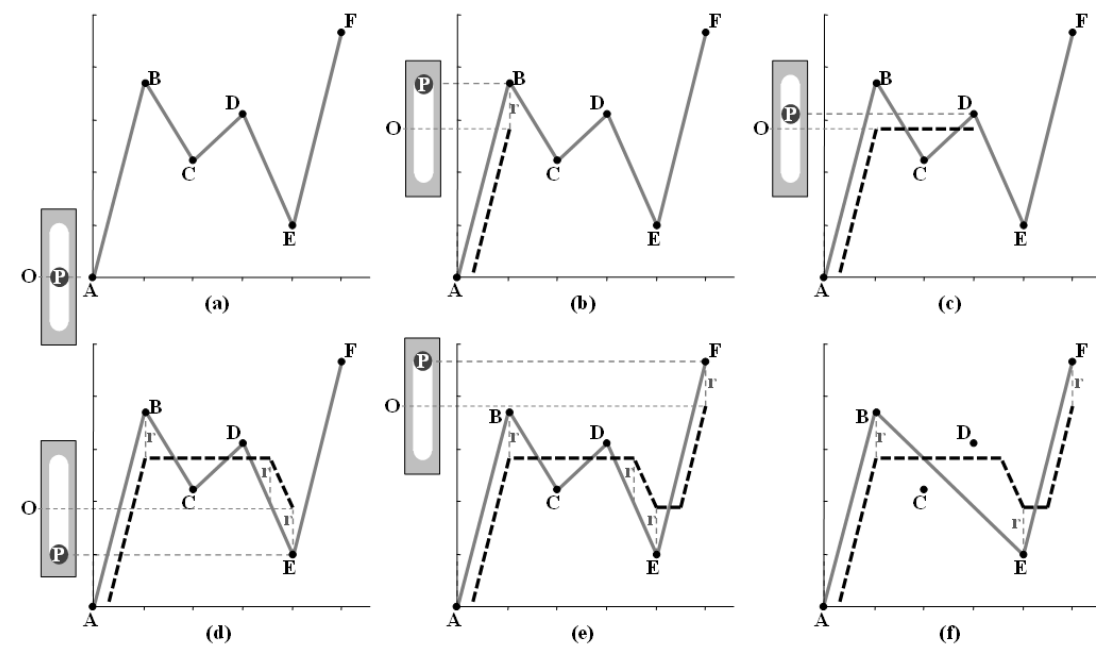
Figure 2: Physical analogy between the uniaxial racetrack filter and a peg oscillating inside a slotted plate with center O and slot range 2r . The peg P oscillates according to the original history, resulting in translations of O represented by the dark dashed line.